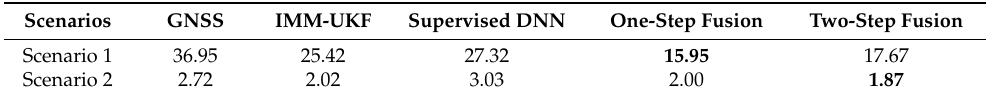
Table 1. The mean location errors of four